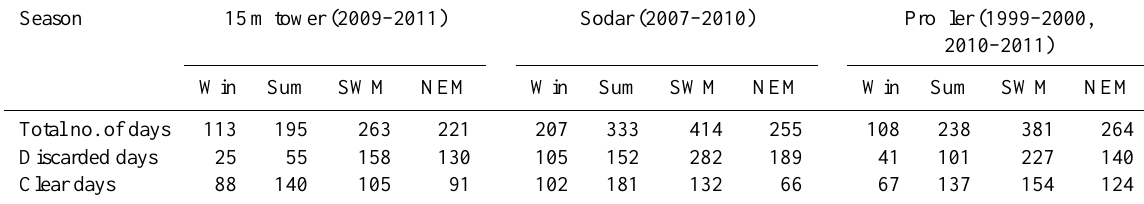
Table 4. Details of data set 1 grouped as a function of season, showing the total number of days for which data are available, number of discarded days due to cloudy sky/rain or data gaps and number of clear days finally used in the present study. Win, Sum, SWM and NEM stand for, respectively, winter, summer, southwest monsoon and northeast